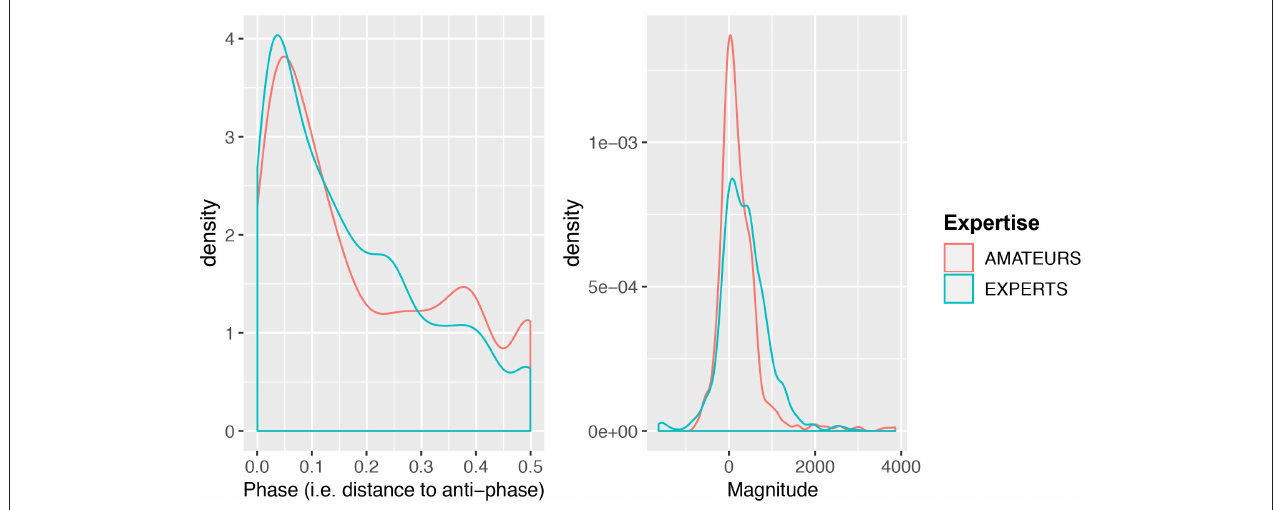
FIGURE 6 | Density plot of relative phase (coded as distance to anti-phase) and magnitude in flexor and extensor muscles between the two expertise groups.